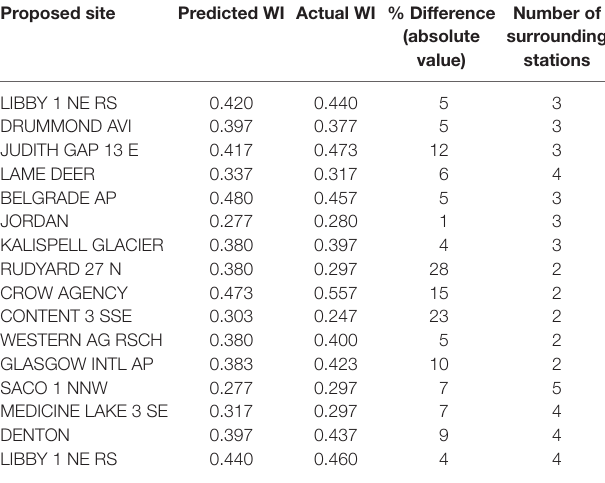
TaBle 2 | Validation results of proposed weather index model.